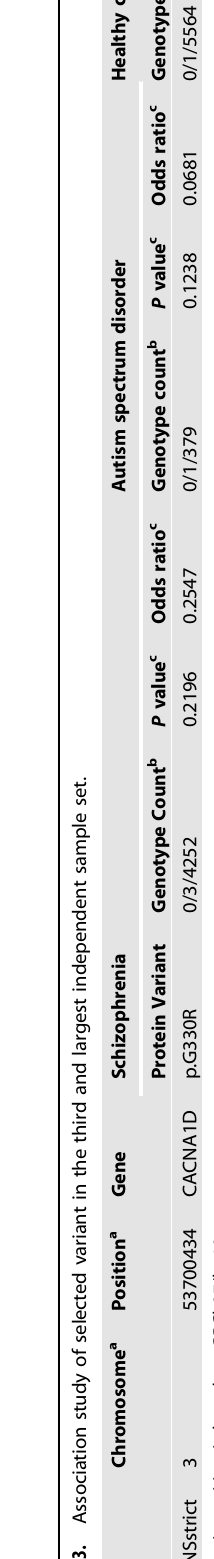
NSCaTE region of Ca v 1.2 (Fig. 2d). To determine the electrophysiological characteristics of the A36V Ca v 1.2 channels, we recorded whole-cell Ba 2 + currents through recombinant Ca v 1.2 channels transiently expressed in BHK- α 2 δ + β 2 cells [45]. The current – voltage (I – V) relationship for the neuronal A36V Ca v 1.2 channel was similar to that for the WT channel. The peak current density (peak current amplitude divided by cell capacitance) for the neuronal A36V Ca v 1.2 channel (15.8 ± 2.0 pA/pF, n = 18) did not differ signi fi cantly from that of the neuronal WT Ca v 1.2 channel (19.8 ± 2.9 pA/pF, n = 12) (Fig. 3a, b), consistent with a lack of a mutation effect on channel membrane traf fi cking (Fig. 1d – f). The steady-state inactivation curves for both channels were very similar (Fig. 3c). These results suggest that the A36V mutation does not change the voltage dependency of activation and inactivation of the neuronal Ca v 1.2 channel. Finally, we examined the effect of A36V on global CDI. This parameter was tested with the use of the pipette solution containing 0.5 mM EGTA. We recorded Ba 2 + and Ca 2 + currents at 30 mV from the same BHK cell expressing neuronal Ca v 1.2 (Fig. 3d – f). Ba 2 + currents decayed slowly, but Ca 2 + currents decayed completely within 350 msec (Fig. 3d). The ratio of remaining current amplitude to the peak current amplitude was calculated at different time points after depolarization to 30 mV (Fig. 3e, f). Ca 2 + currents (Fig. 3f), but not Ba 2 + currents (Fig. 3e) of neuronal A36V Ca v 1.2, were reduced mildly, but signi fi cantly more slowly, than Ca 2 + currents of the neuronal WT Ca v 1.2, suggesting that the A36V mutation affects global CDI in neurons. We further examined the impact of A36V in the cardiac isoform that contain the longer N-terminal region encoded by exon 1a (Fig. 3g – i). In contrast, Ca 2 + currents (Fig. 3i) and Ba 2 + currents (Fig. 3h) of cardiac A36V Ca v 1.2 decayed similarly to those of cardiac WT Ca v 1.2. The reported electrophysiological properties of the A39V Brugada mutation in a neuronal isoform is more complex [54], suggesting co-existing overlapping pathophysiology of the A39V mutation, especially in cardiac mutant channels. Taken together, these data indicated that A36V neuronal Ca v 1.2 is a mild gain-of-function mutant channel, while the A36V cardiac Ca v 1.2 behaves similarly to the WT channel, consistent with the relatively late onset of SCZ symptoms and normal cardiac